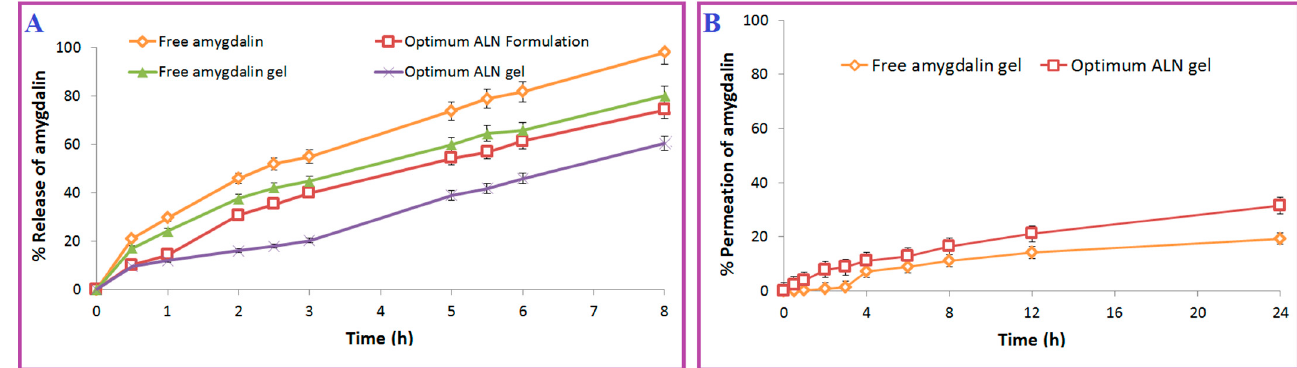
Figure 4. Release ( A ) and permeation ( B ) profiles of optimum ALN gel